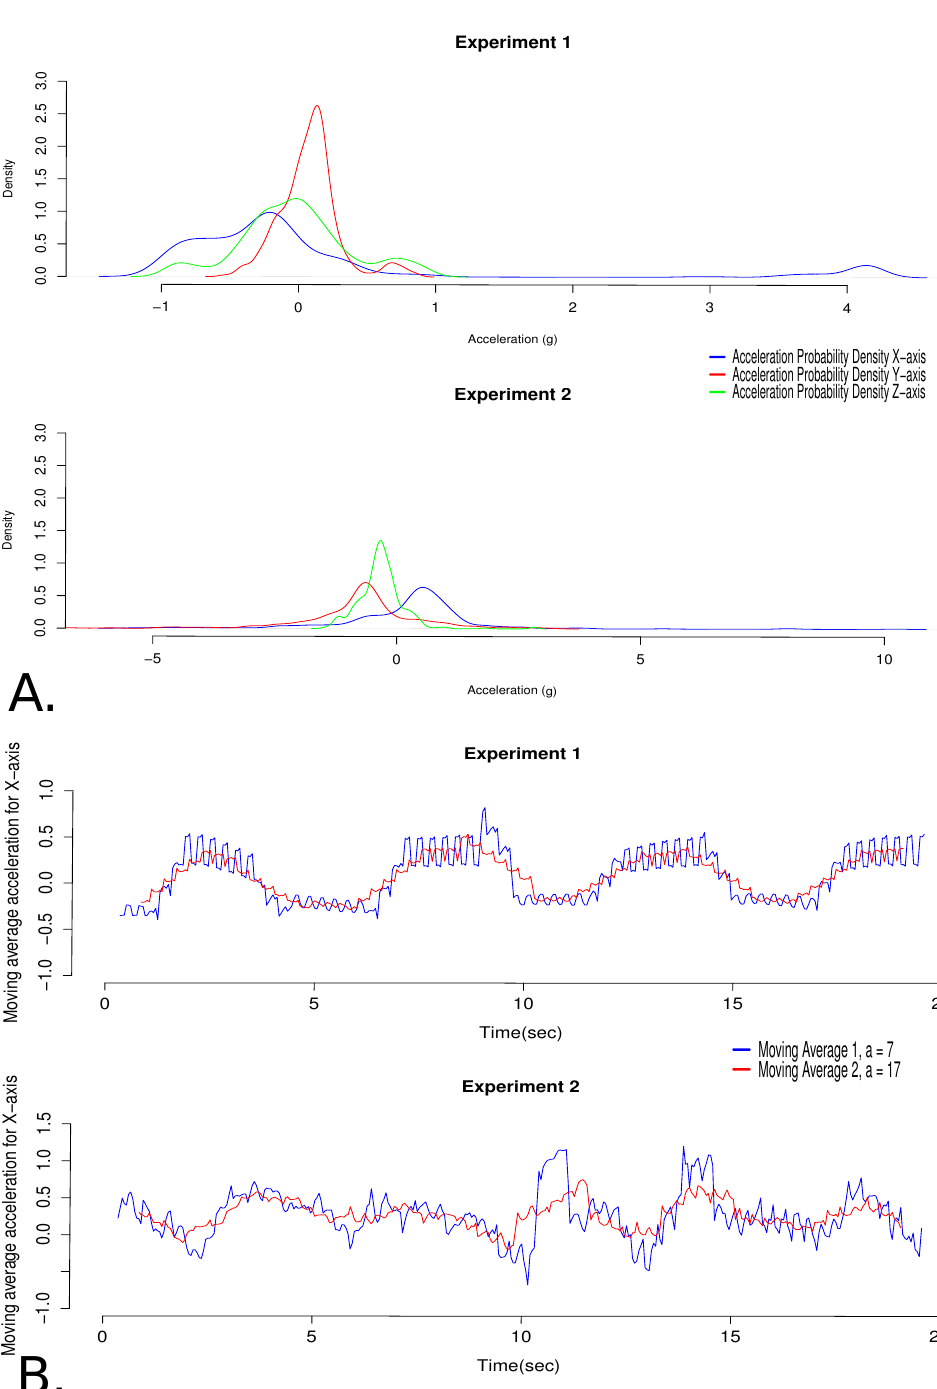
Figure 6. Statistical comparison of acceleration signals: ( A ) Kernel densities for acceleration signal (three-axes). Experiment 1 data shows the magnitude of x-axis acceleration as an increase in probability density near 4 g. The unstable signal from Experiment 2 does not give any indication about the dominant process, since the distributions of the three axis signals are statistically similar; ( B ) Moving Average Smoothing are the caps necessary of x-axis acceleration signals. Linear filters ( a = 7 and a = 17 ) retain the periodic pattern during Experiment 1 with an approximate period of 5 s, while for Experiment 2, there is no indication of this